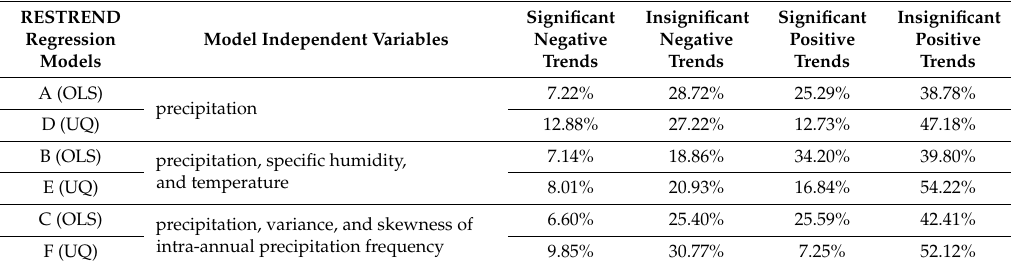
Table 6. Percentage land area with significant negative and positive trends. OLS—ordinary least squares; UQ—upper quartile